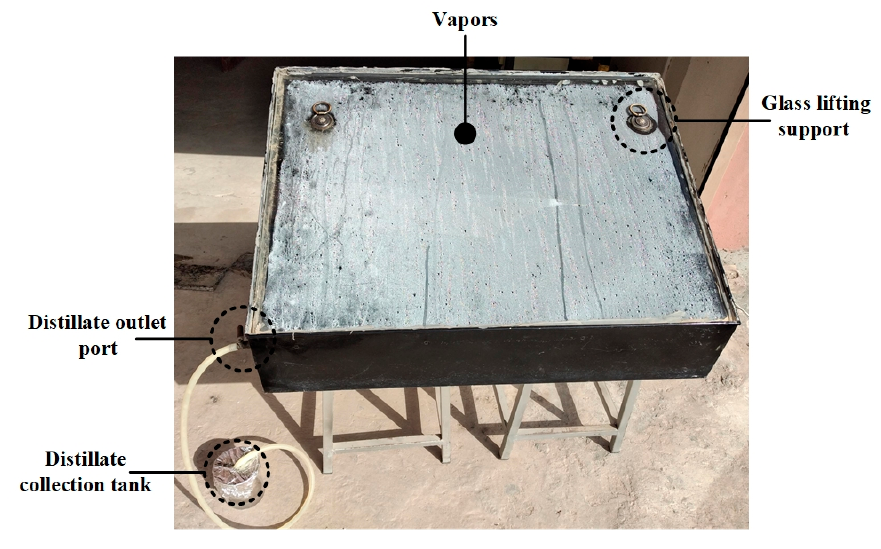
Figure 3. Single slope solar still experimental setup.